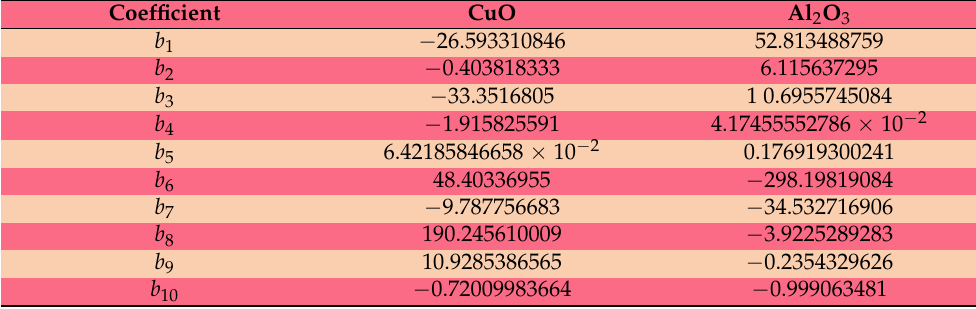
Table 2. The coefficient values of CuO and Al 2 O 3 nanoparticles ([43]).